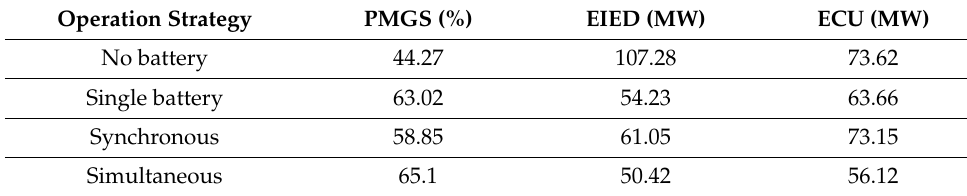
Table 6. Performance indices of BESS-integrated wind farm with 2 MW battery.